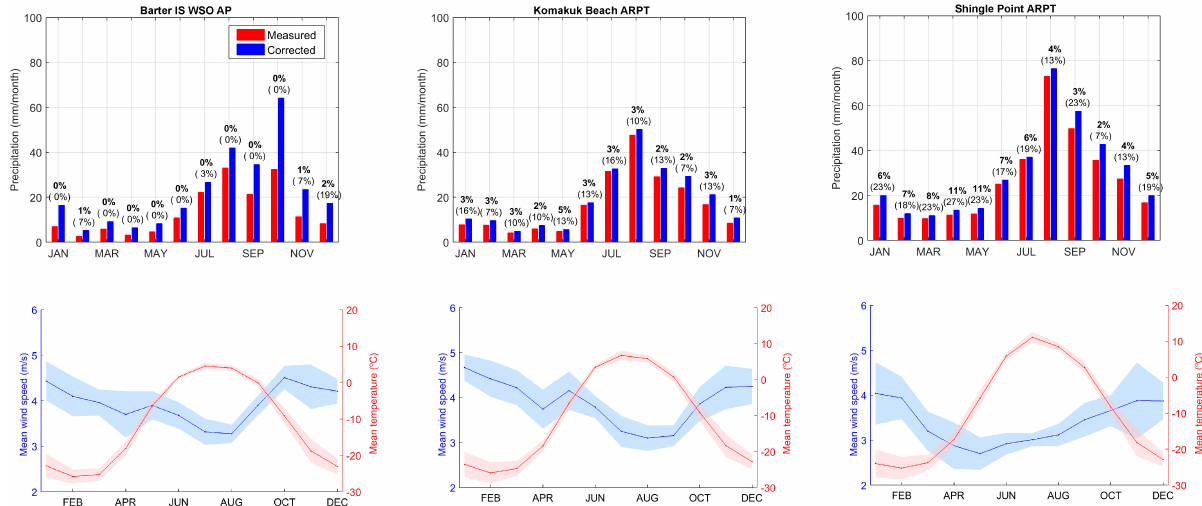
Figure 2. Monthly mean precipitation at three stations during 1977–1988 (upper panels) and corresponding monthly mean wind speed and air temperature (bottom panels). Shadows represent the 95% confidence interval for the temperature and wind speed. The percentages above the bars represent the missing data for the corresponding time step. The bold percentage is the monthly mean, and the one in the parentheses is the maximum missing value in the study